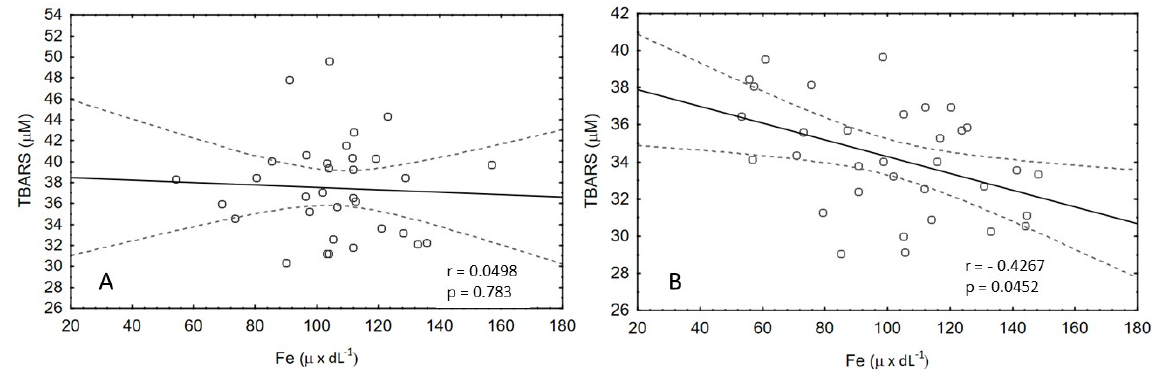
Figure 5. Correlation between TBARS and iron concentrations in colostrum before ( A ) and after supplementation ( B ). supplementation ( B